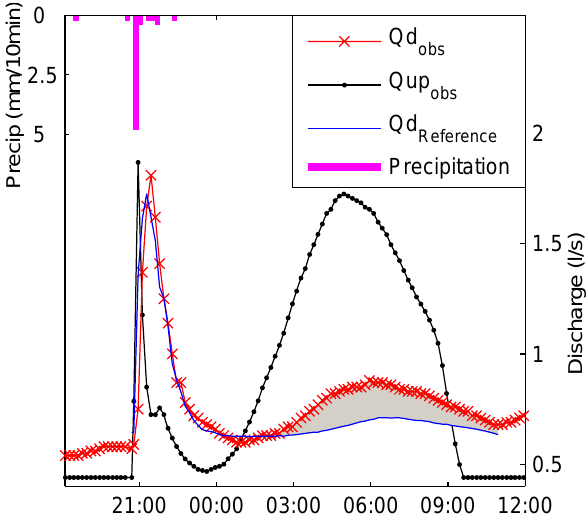
Fig. 2. Observed and simulated discharge of second peak on 22 and 23 June 2008, using the same parameters as during the first discharge peak. The subscripts d and up refer to downstream and upstream. The shaded area is the difference between observed and simulated